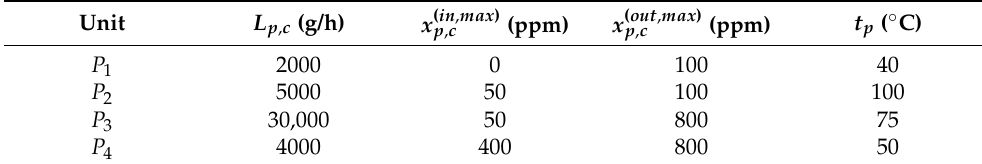
Table 2. Process water-using units data for Example 1.